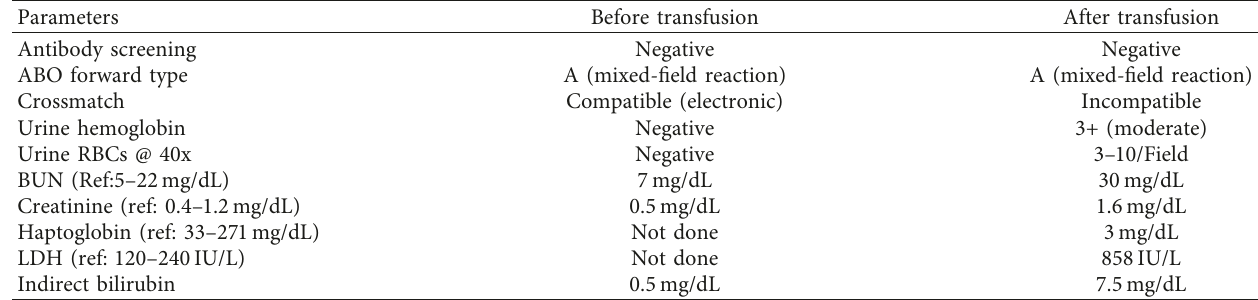
Table 1: Laboratory parameters before and after the transfusion